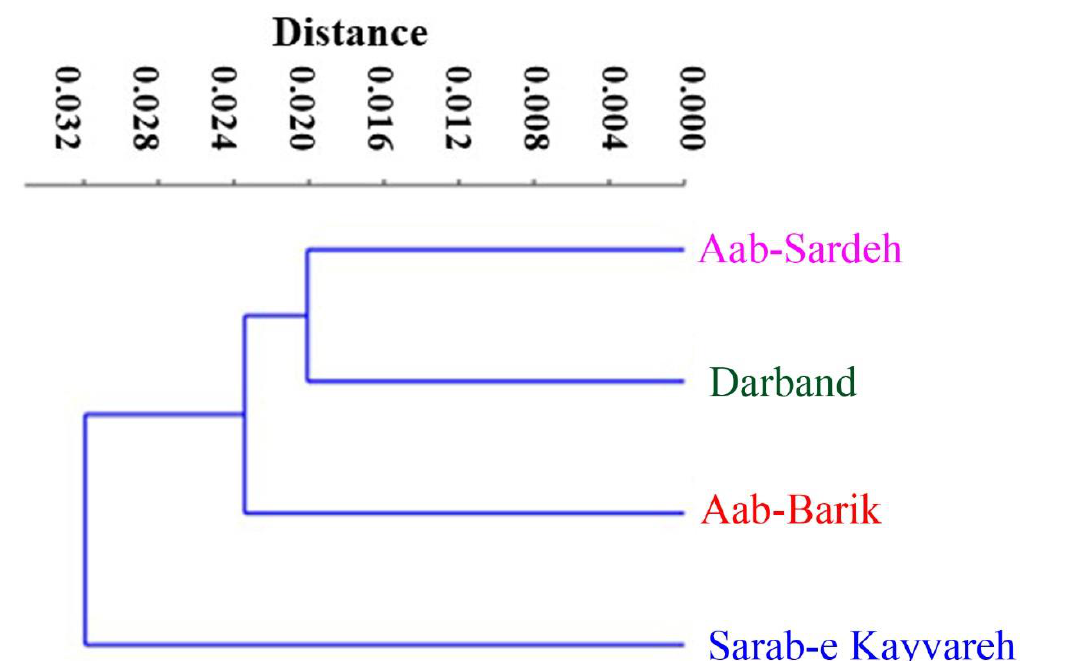
Meristic characters Based on normality test, all meristic characters were nonparametric except lateral line scales (LL) and pre- dorsal scales, so they were analysed with Kruskal–Wallis and ANOVA, respectively (Table 2) and showed D